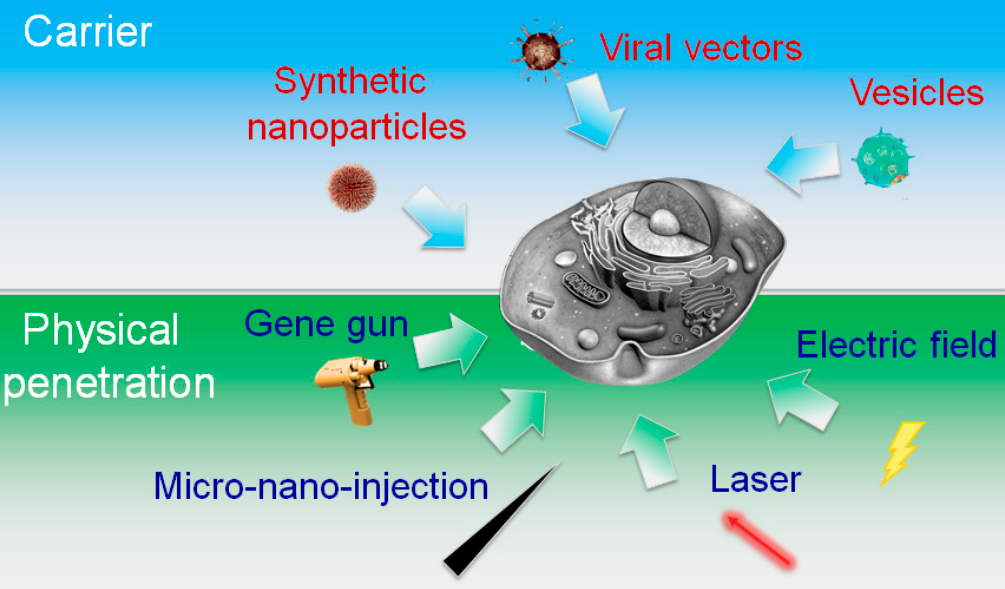
Figure 2. General classification of popular intracellular delivery platforms: carrier-mediated delivery strategies (blue background) and popular physical membrane-penetrating delivery methods (green background).